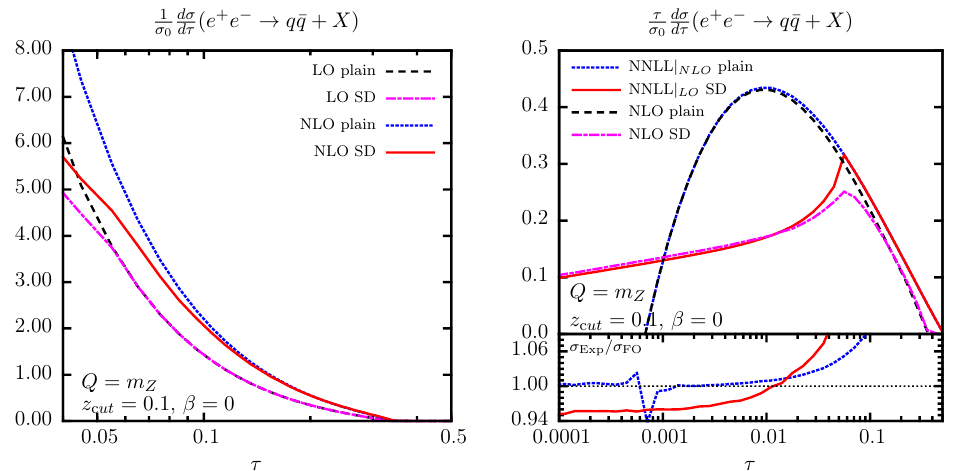
Figure 8 . On the left, the thrust distribution, with and without soft drop, in (cid:12)xed-order pertur- bation theory, namely at LO and NLO. On the right, comparisons of (cid:12)xed-order results to the expansion of the NNLL resummation.